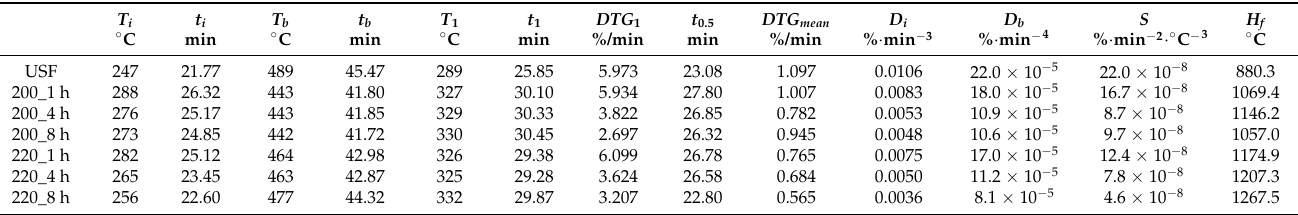
Table 2. Combustion parameters estimated by means of thermogravimetric